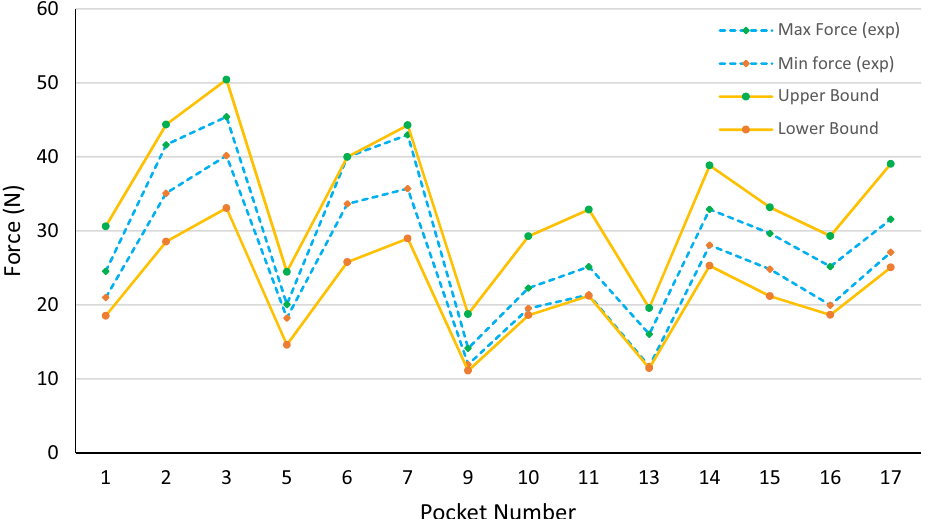
Figure 16. The range of measured push-out forces and calculated upper and lower bonds with six sigma variations in material properties, 0.02 mm in pocket width, and 0.05 mm in other dimensions for PA66 cages.